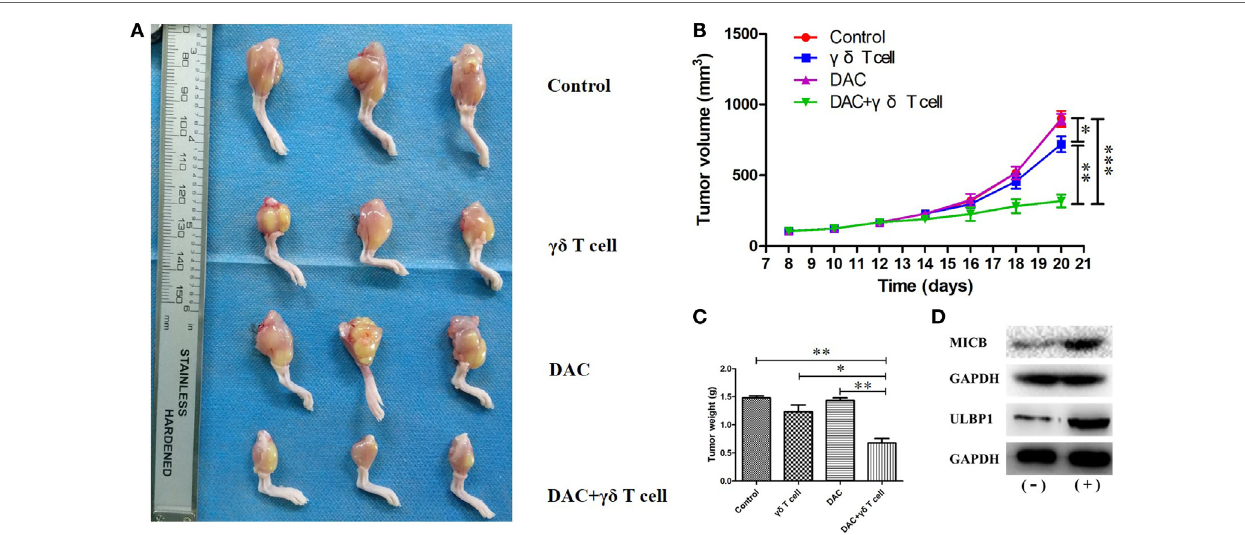
FigUre 7 | Mice receiving both γδ T cells and decitabine (DAC) showed significantly reduced tumor growth. (a) Mice from groups treated with γδ T cells + DAC showed less tumor burden than those mice untreated (control) or treated with DAC or γδ T cells alone. (B) Tumor volumes are significantly smaller in the group treated with γδ T cells + DAC compared with the control or DAC or γδ T cells group. (c) The group treated with γδ T cells + DAC showed significantly reduced tumor weight compared with the control or single-treatment group. Error bars show SD among the replicates. (D) Western blot confirmed that DAC treatment increased expression of MICB and UL16-binding protein 1 (ULBP1) in vivo . ( − ): without DAC treatment; ( + ): DAC treatment (ns refers to no significance; * P < 0.05; ** P < 0.01; *** P <